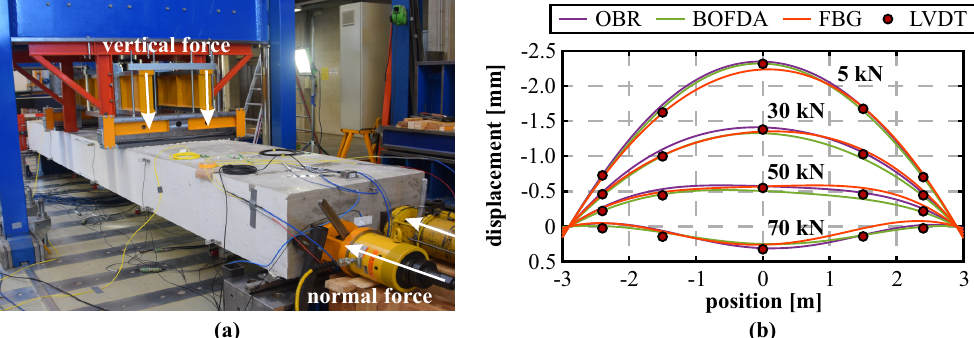
Figure 15. Combination of vertical loading and normal force: ( a ) Test setup. ( b ) Displacement curves derived from DFOS strains and measured by